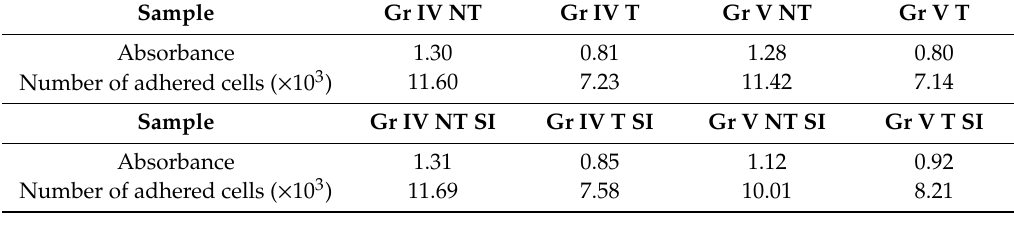
Figure 14. Graph of the results of culture of mother cells on different samples.